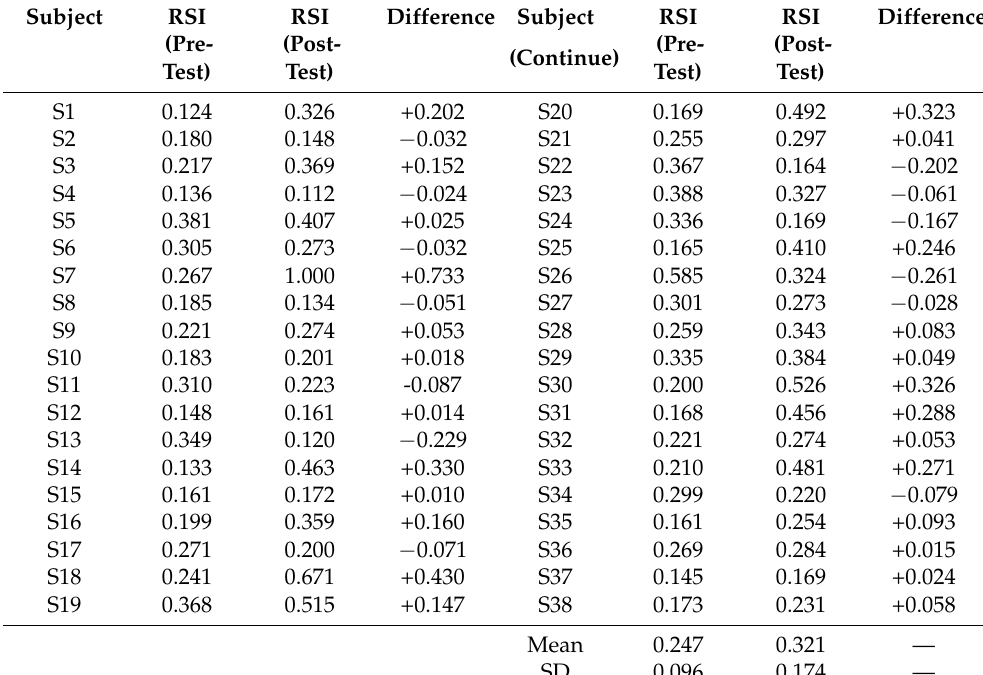
Table 3. Pre-test and post-test RSI for each subject. (Difference = RSI (post-test) − RSI (pre-test)).